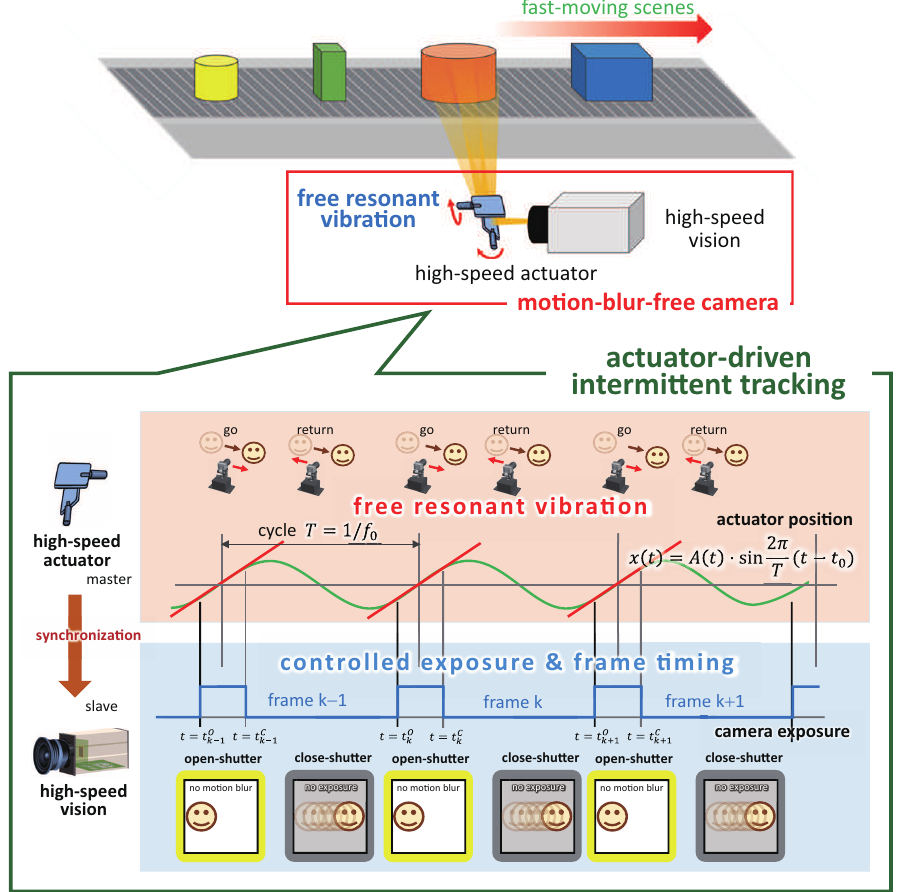
Figure 2. Concept of the actuator-driven frame-by-frame intermittent